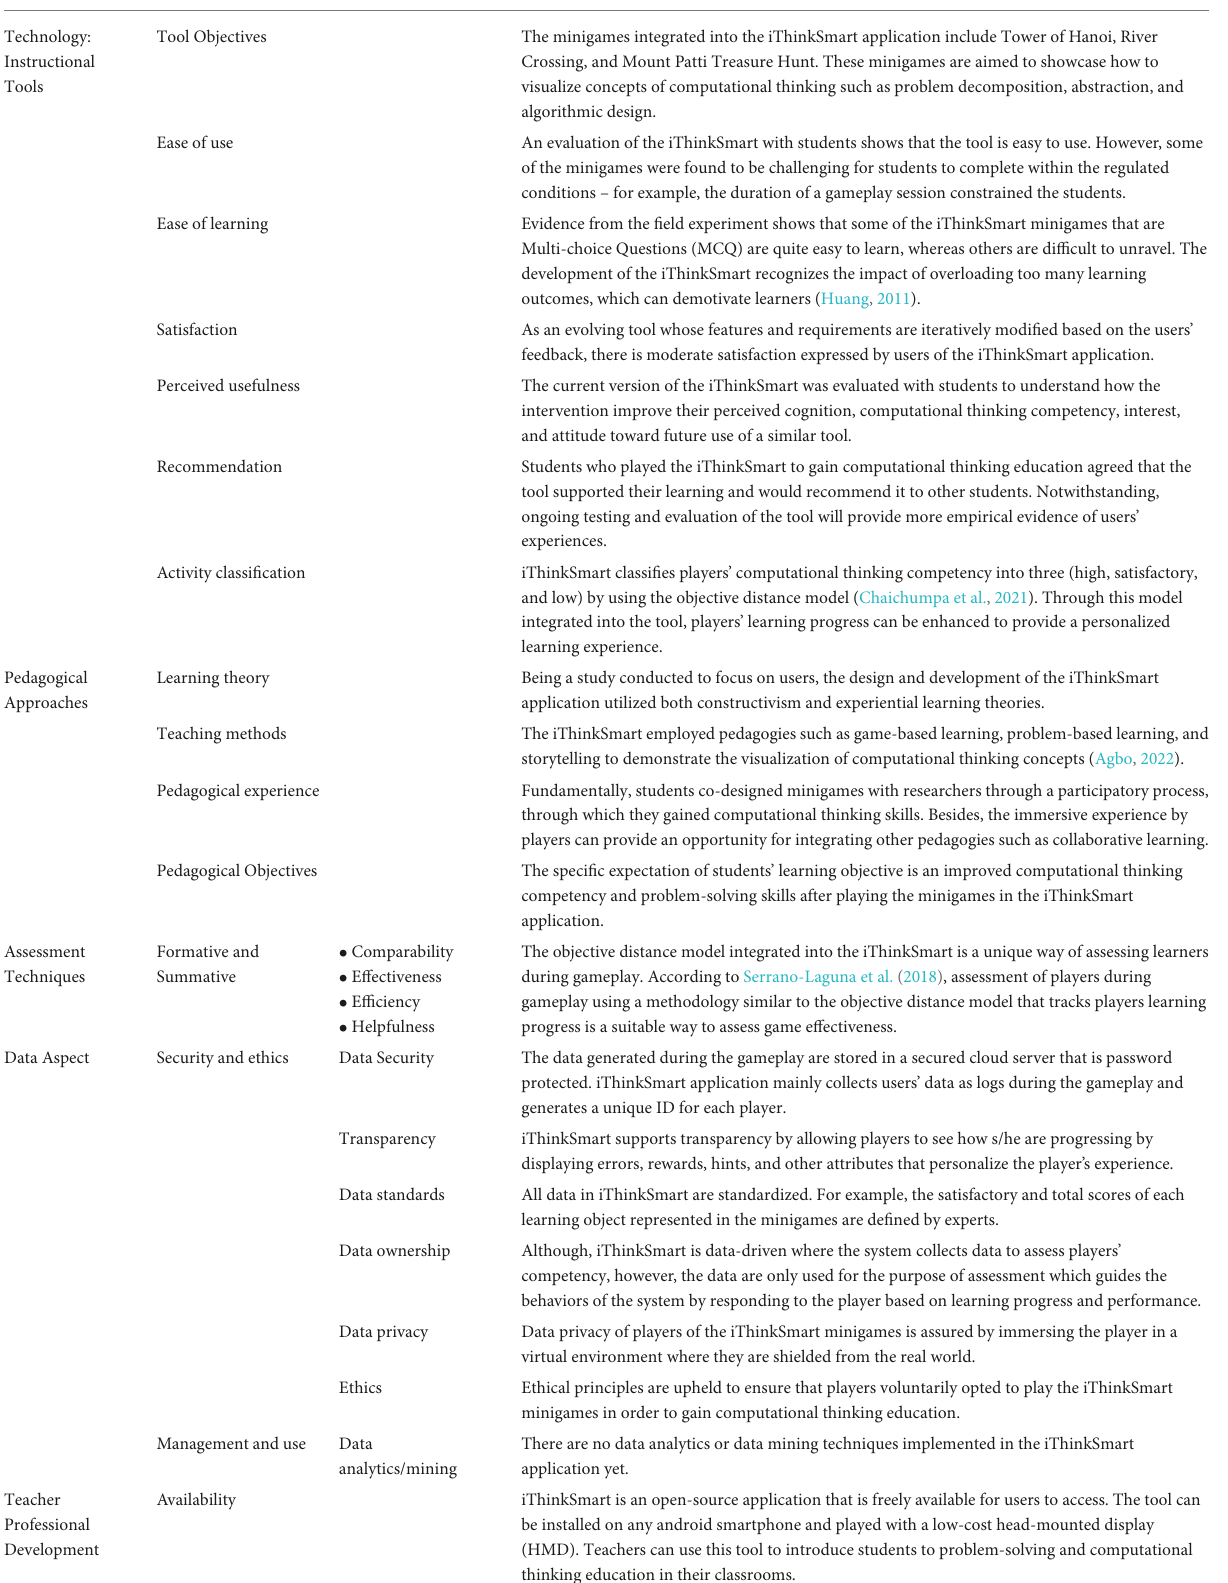
TABLE 5 Evaluation of iThinkSmart based on